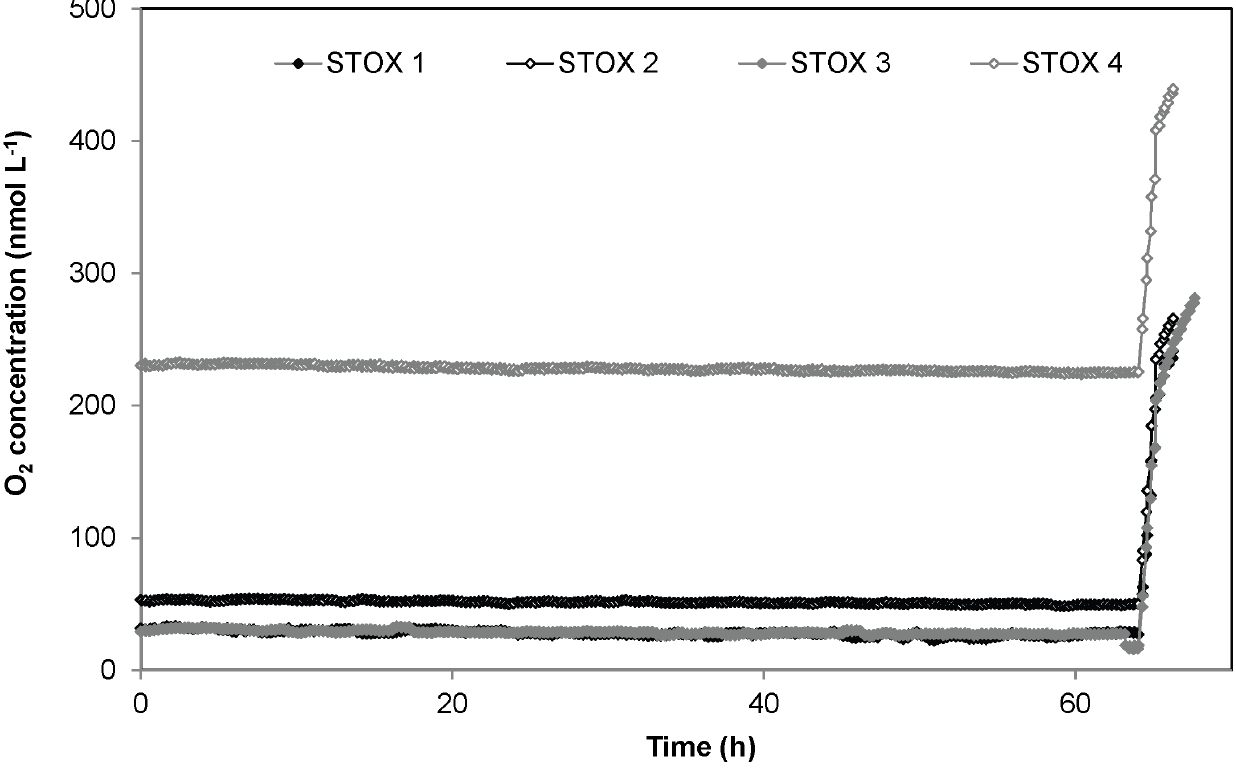
Figure 2. Results from the control experiment (Exp. 1). Four different replicates with different oxygen concentrations are shown. A 64 h 1 mL of air saturated 0.05 M HCl in Milli-Q water, corresponding to 244 nmol L 2 1 O 2 , was added for sensor calibration.